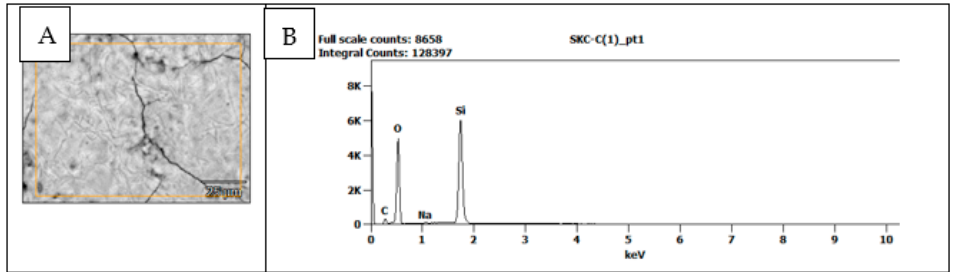
Figure 3. SEM image of the morphology of the aerosol droplet microarea for R1 solution ( A ) and the spectrum of the chemical content of the examined microarea ( B ).